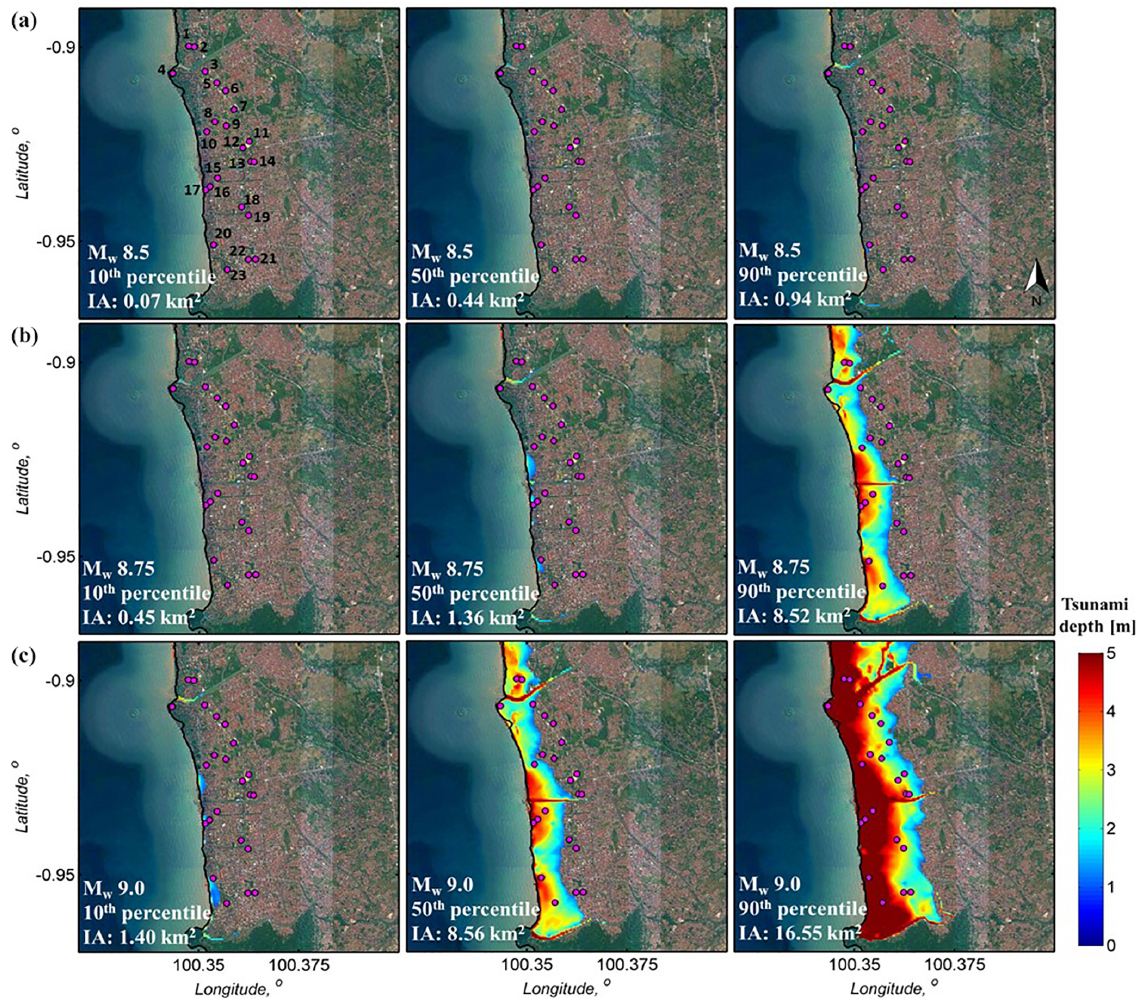
Figure 9. Inundation areas above 1m depth in Padang: (a) M w 8.5 scenario, (b) M w 8.75 scenario, and (c) M w 9.0 scenario (IA is inundation